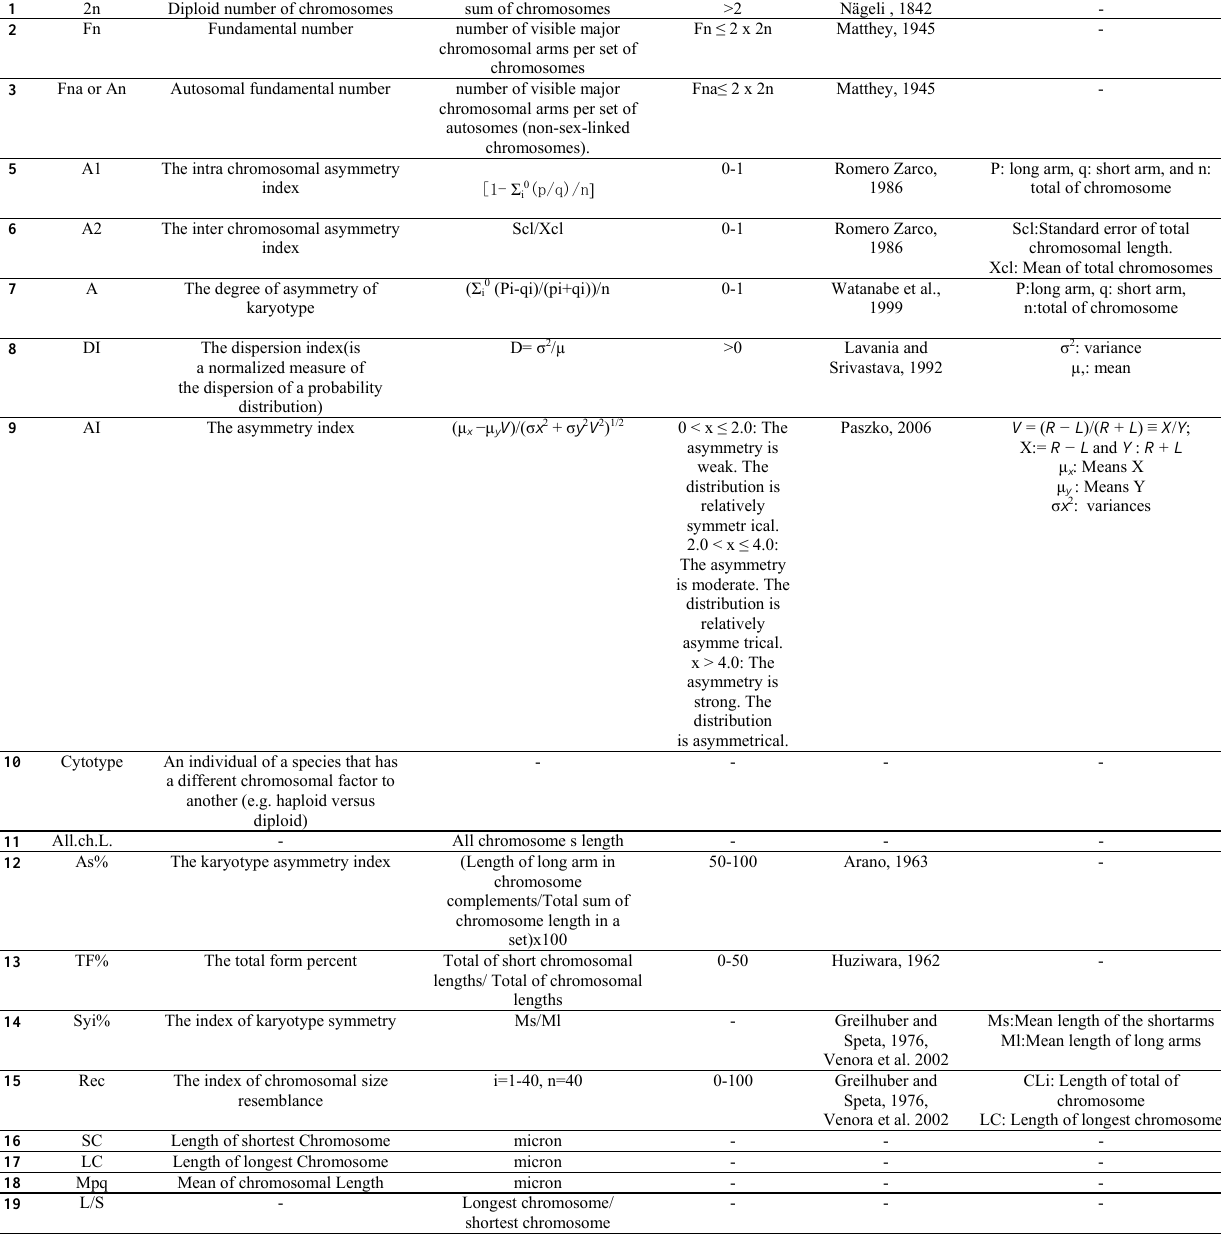
T ABLE 3. Comparison of karyological records of the studied house mouse populations. Black color : M. m. musculus , Red color : Birjand ( Mus musculus bacterianus.) , Blue color : M. m. castaneus and M. m.